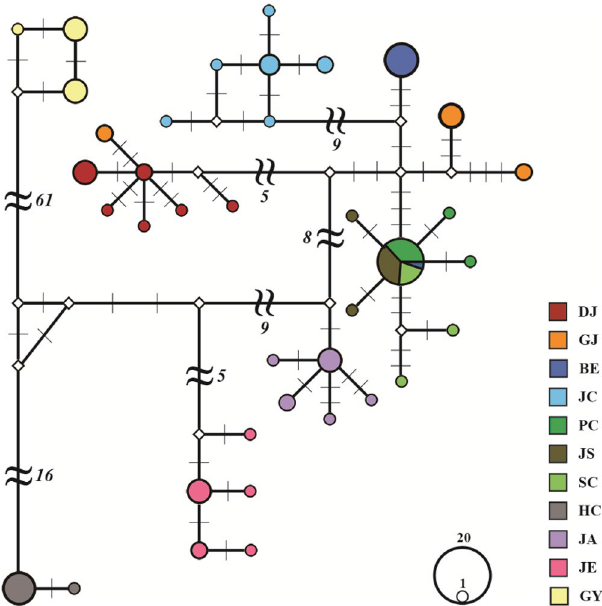
Figure 2. Haplotype network among Karsenia koreana populations estimated using concatenated sequences of cytochrome c oxidase I and cytochrome b . Different colors are assigned to each population, and the size of a circle is proportional to the haplotype frequency. Mutation steps are indicated by vertical lines, or numbers in case of more than five. Population codes follow Table